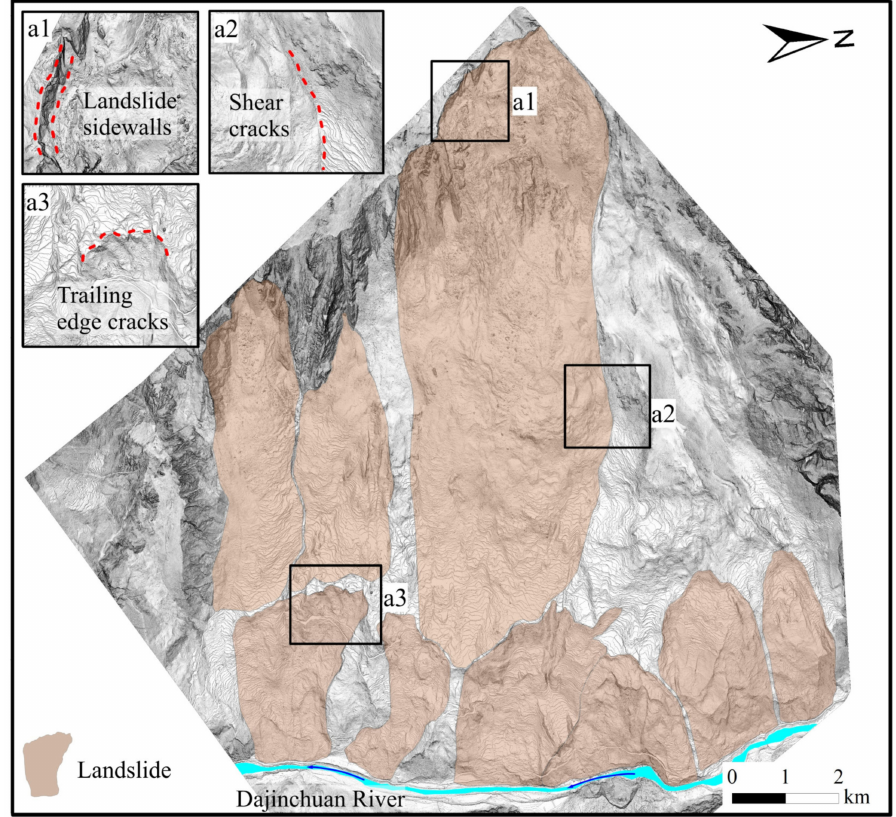
Figure 5. Micro-geomorphic identification of sub-landslides based on SVF: ( a1 ) Landslide sidewalls, ( a2 ) shear cracks, ( a3 ) trailing edge